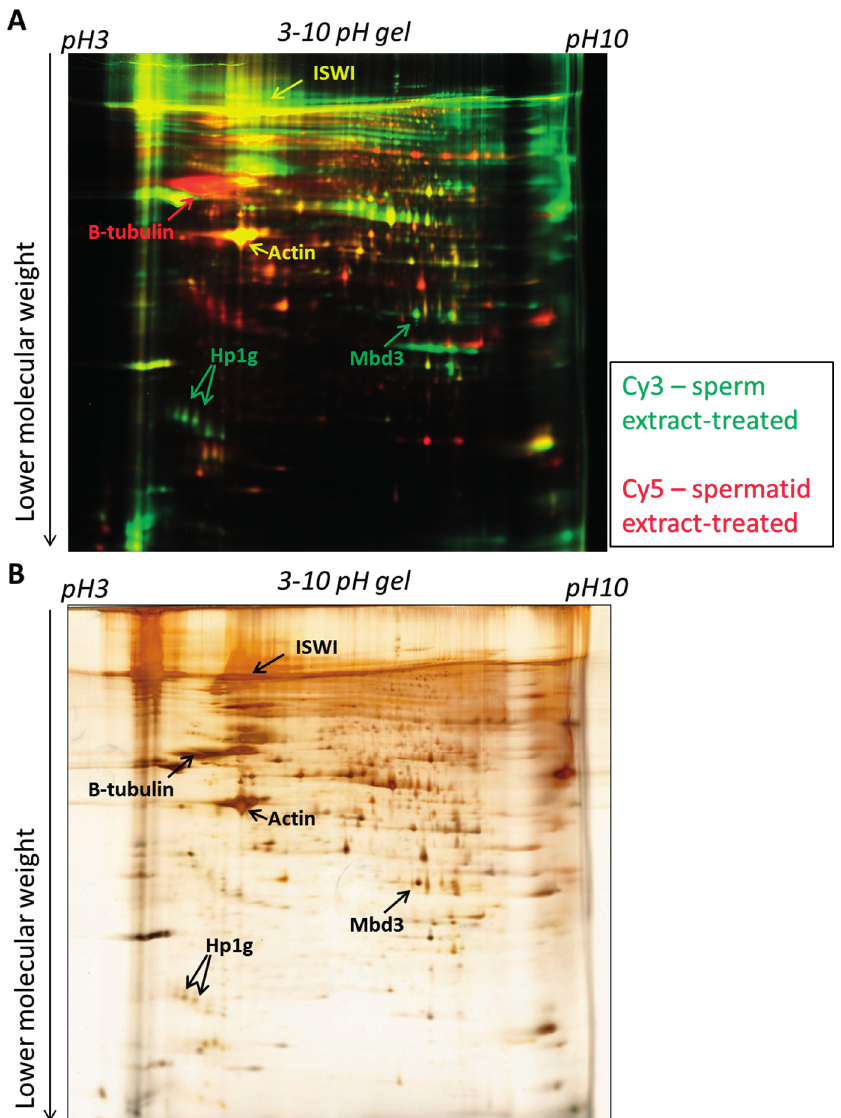
Figure 6. 2D-DIGE electrophoresis of sperm-extract treated and spermatid-extract treated. ( A ) Proteins bound to sperm chromatin after egg extract treatment (green) were run on a pH 3–10 gel together with proteins bound to spermatid chromatin after egg extract treatment (red). Examples of proteins binding specifically to sperm (green), spermatid (red) or to both types of cells (yellow) are indicated with arrows; ( B ) The same gel as in ( A ) silver-stained to allow protein spot visualisation and excision. Examples of proteins are indicated with